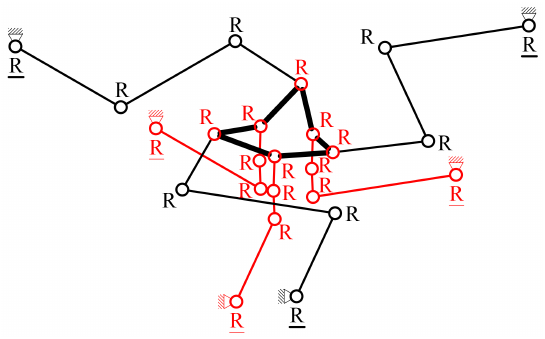
Figure 1. Configuration scheme of the new spatial 6-RRRR CPM.